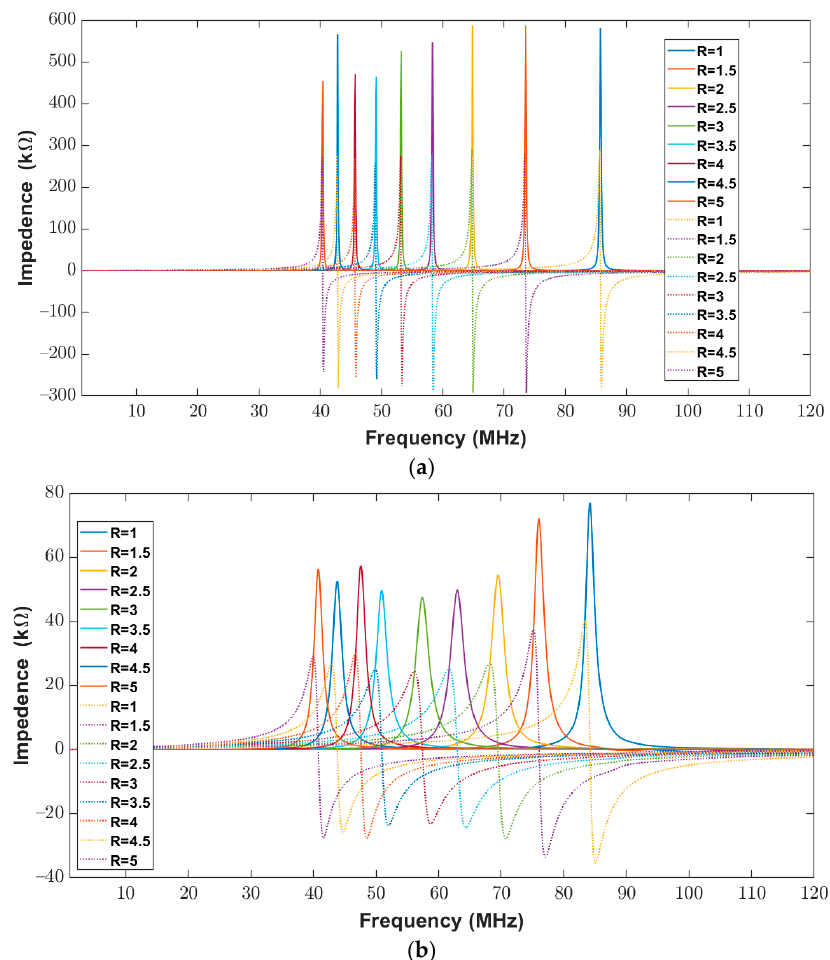
Figure 17. Impedance (Real (solid lines) and Imaginary (dotted lines) components) of elliptical planar inductors for the full range of frequencies from 20 Hz to 120 MHz with varying major-to-minor ratios while trace separation ( S ) and trace width ( W ) were kept constant at 400 μ m ( a ) Computed response using proposed model ( b ) Measured response from the impedance analyzer.